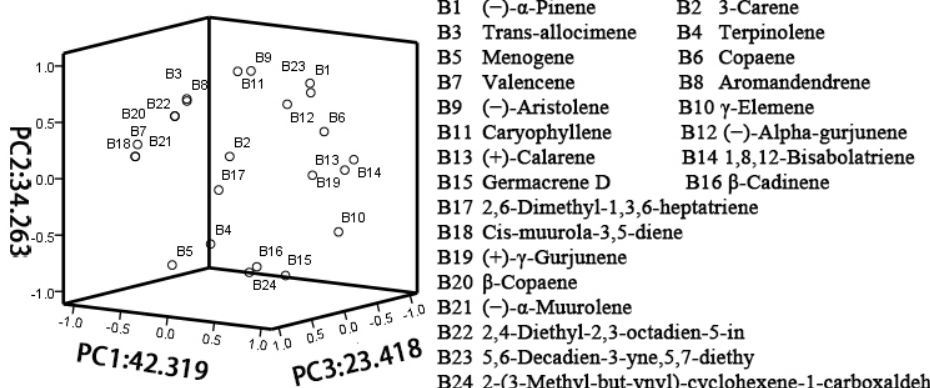
Figure 3. A 3D loading diagram of eigenvector loading values of 24 volatile components from PC1, PC2, and PC3, from different varieties of P. notoginseng flowers.